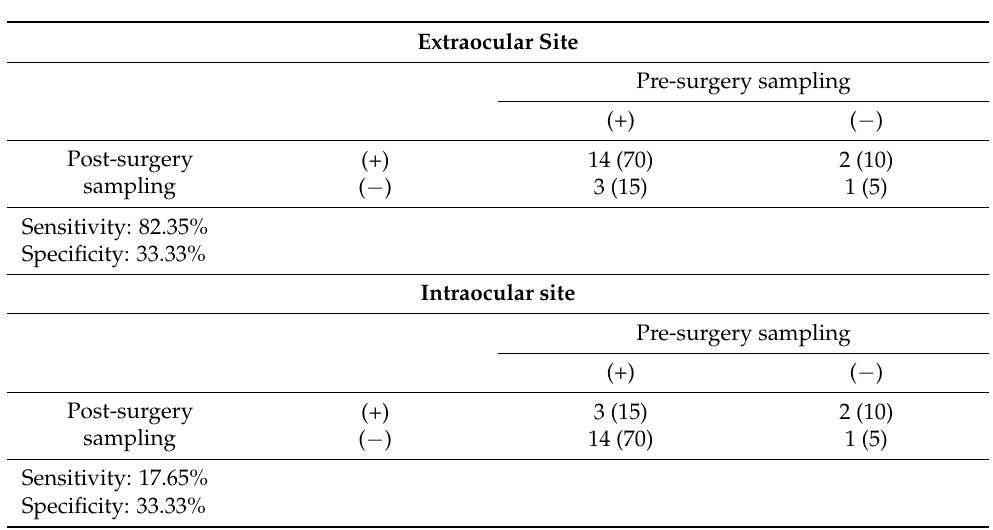
Table 2. Method sensitivity and specificity of the microbial sampling site at the extraocular and intraocular sides of the corneoscleral rim.